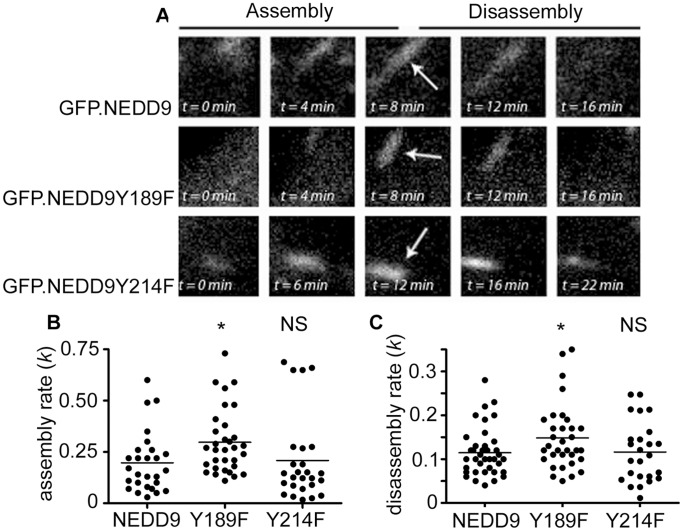
Mutation of NEDD9Y189 stimulates faster adhesion dynamics.A. Time-lapse microscopy of the assembly and disassembly of GFP-positive focal adhesions. Shown are examples of focal adhesions in NEDD9−/− MEFs transfected with GFP.NEDD9, GFP.NEDD9Y189F and GFP.NEDD9 Y214F. Each box shows a 4.7 µm×4.7 µm cropped region. Arrows point to each adhesion at the time of peak fluorescence intensity. B. Focal adhesion assembly rate constants (k) for the indicated fusion proteins. C. As for B, except data showing the disassembly rate constants (k). N>25 individual adhesions were analysed per condition. *p<0.05, N.S. = not significant.